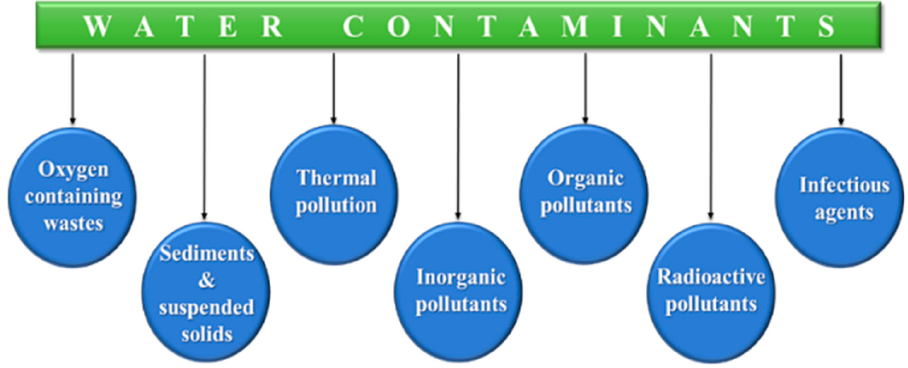
Figure 1. Different pollutants in contaminated water.